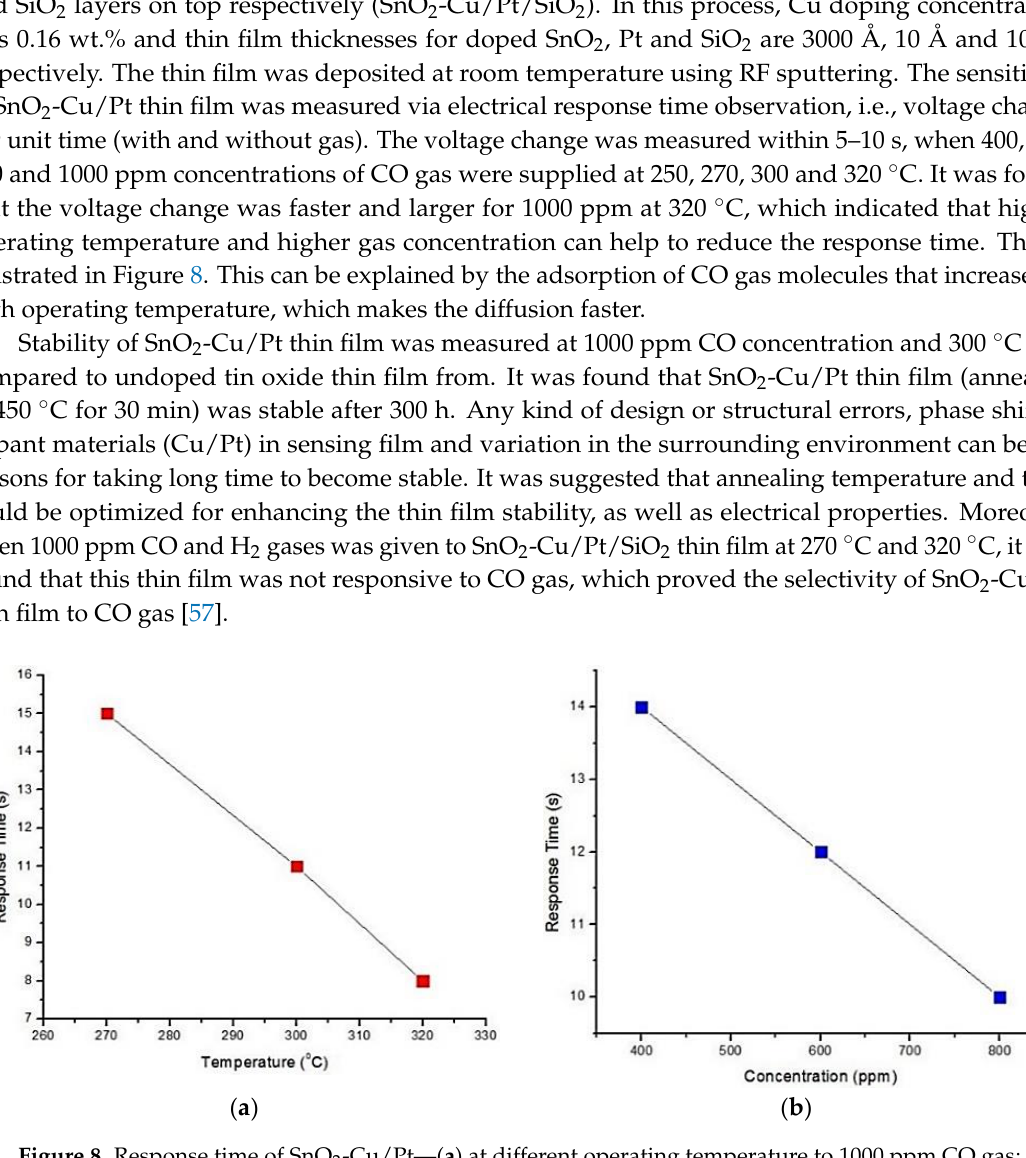
Figure 8. Response time of SnO 2 -Cu/Pt—( a ) at different operating temperature to 1000 ppm CO gas; and ( b ) to different concentrations of CO gas at 250 °C operating temperature.